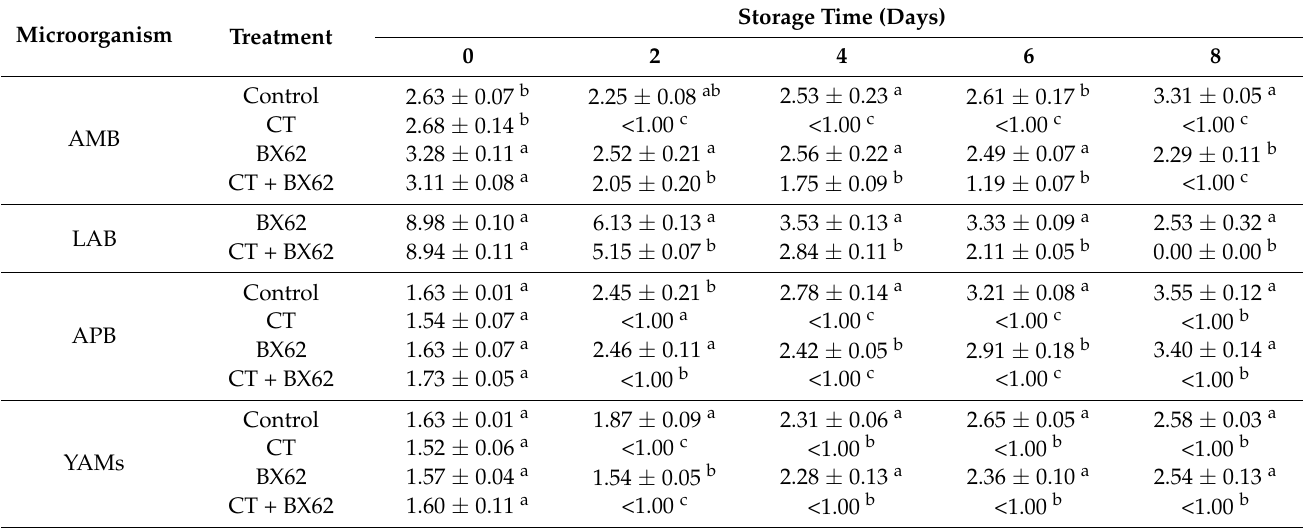
a–c Different lowercase superscripts in the same column indicate significant differences ( p < 0.05). CT = chitosan; BX62 = Lactiplantibacillus plantarum